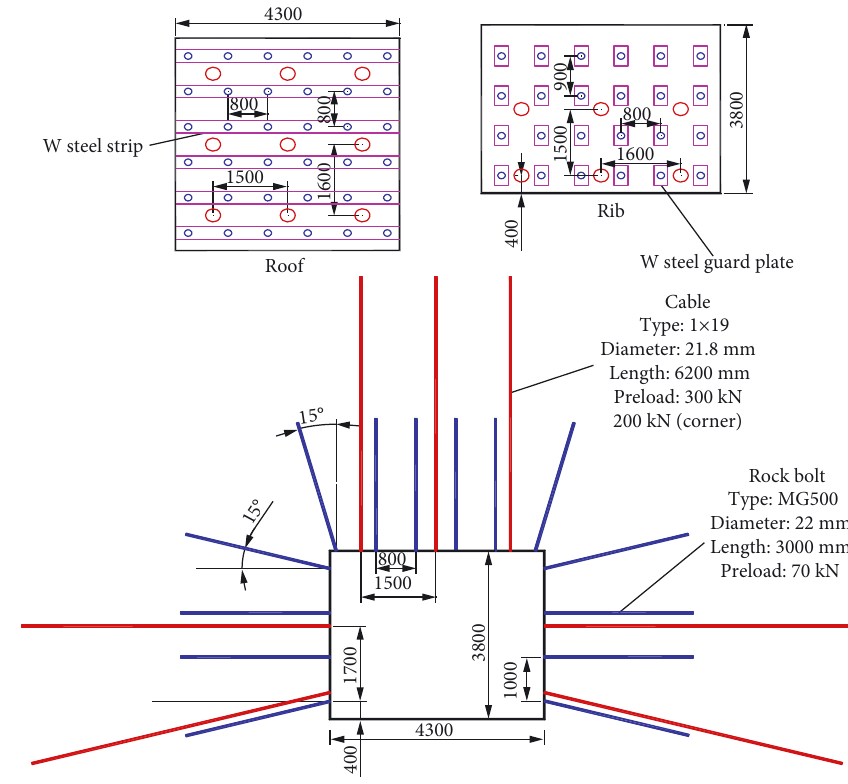
Figure 18: Support plan (mm).